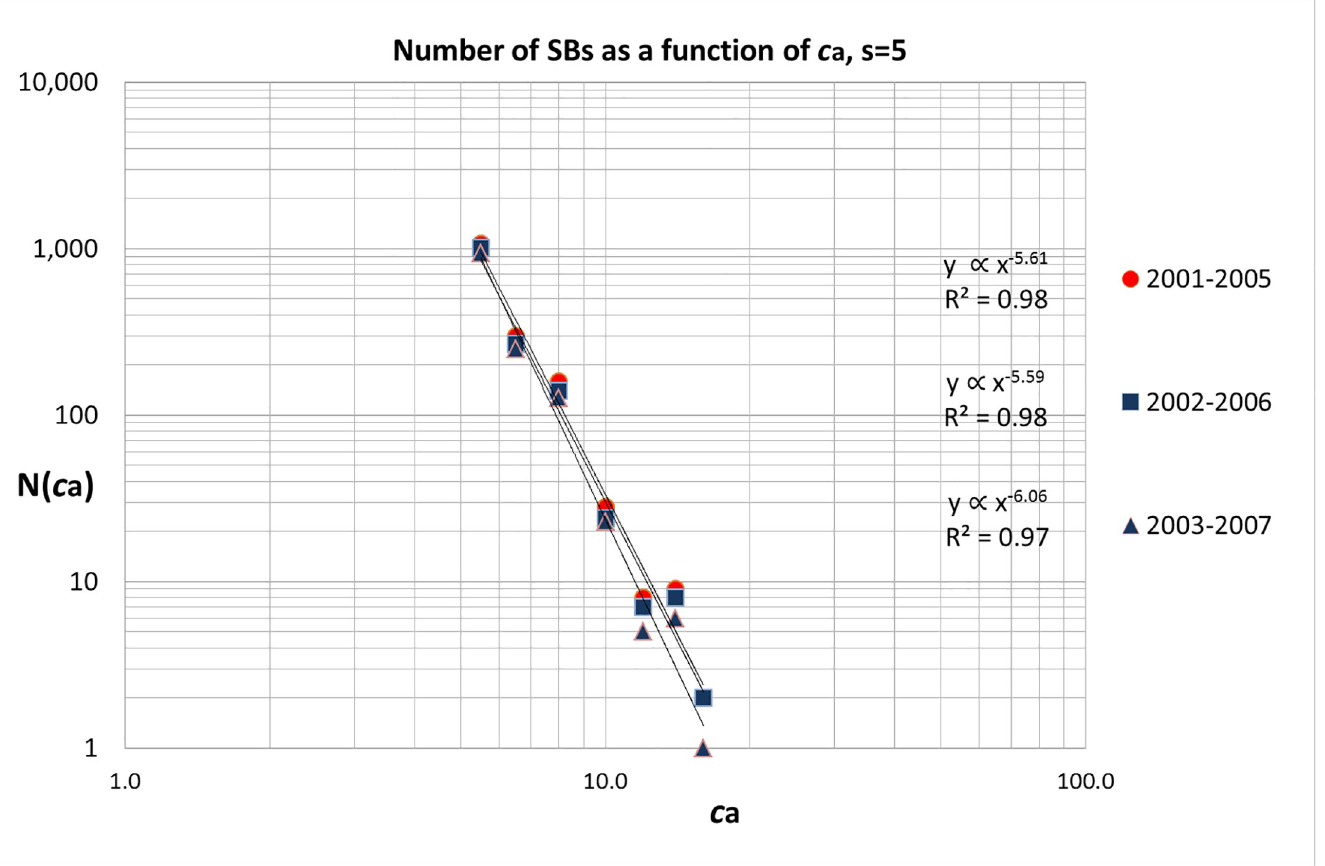
Fig 10. Number of SBs ( s = 5) for successive awakening citation-intensity ( c